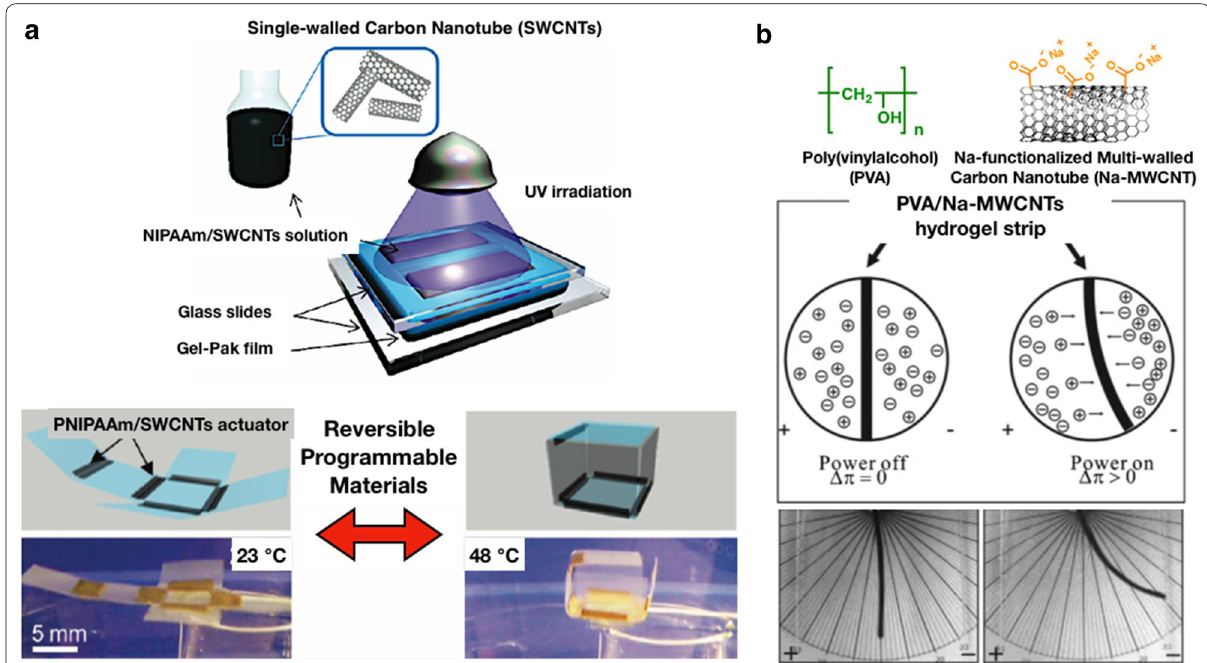
Fig. 6 a Schematic of the PNIPAAm/SWCNTs hydrogel fabrication using Gel-Pak confinement channels and UV curing method. Reversible and programmable folding/unfolding of cube in response to temperature changes, resulting from the PNIPAAm/SWCNTs. (Reproduced with permission from Ref. [52], © 2011, American Chemical Society). b Images of the bent PVA/Na-MWCNTs hydrogel strip with 10%(w/w) containing Na-MWCNTs in 3 mM of Na 2 CO 3 aqueous solution at 10 V/cm DC electric field. (Reproduced with permission from Ref. [53], © 2005, American Chemical